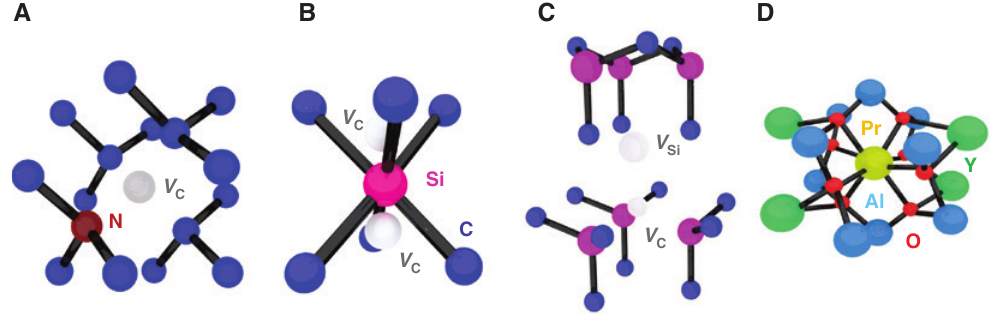
Figure 1: Prominent quantum point defects. (A) Nitrogen-vacancy center in diamond; (B) silicon-vacancy center in diamond; (C) divacancy in 4 H -SiC; and (D) substitutional Pr ion in yttrium aluminum garnett